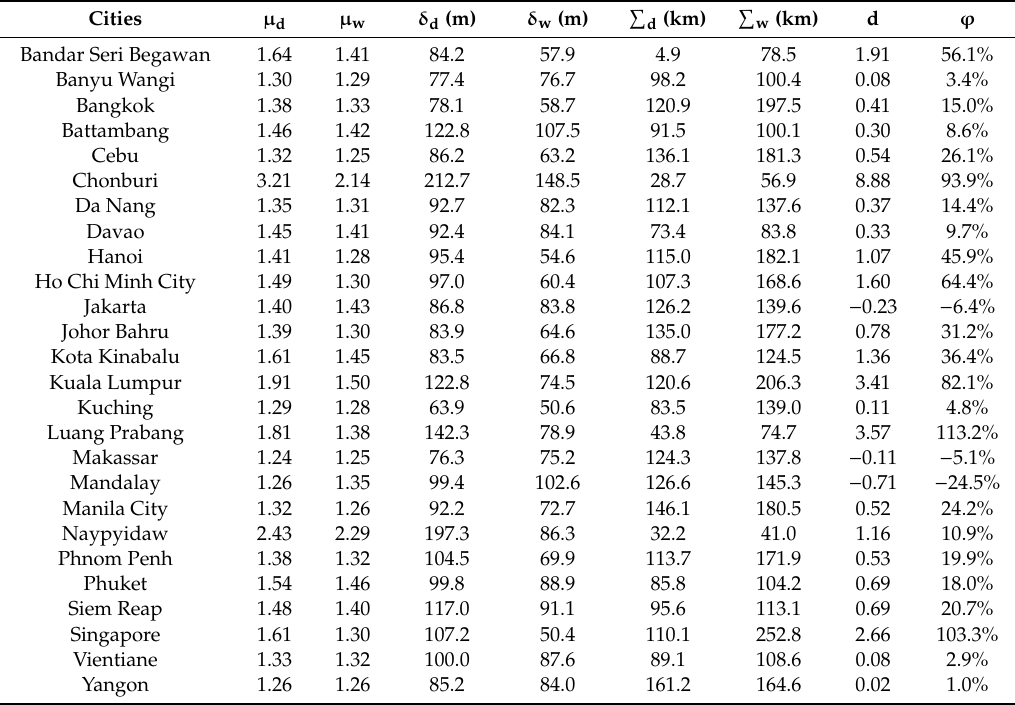
Table 3. The average circuity of driving and walking networks in